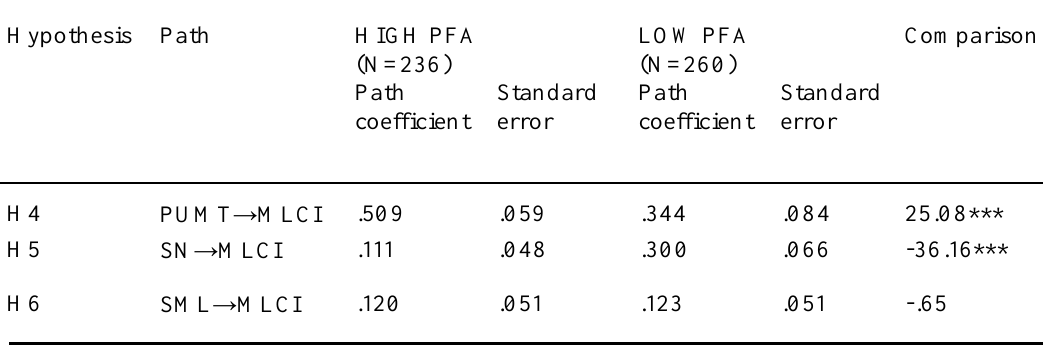
Statistical Comparison of Each Path